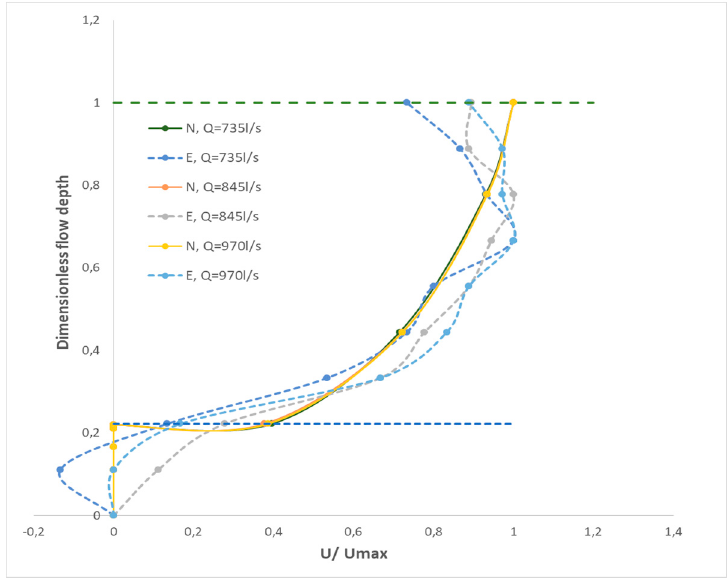
Figure 4. Dimensionless comparisons for h = 9